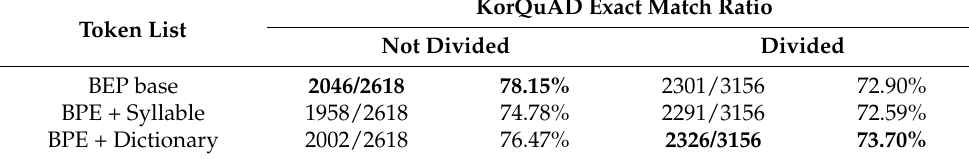
Table 4. Ratio of exact matches based on the separation of morphemes of KorQuAD v1.0 in the small